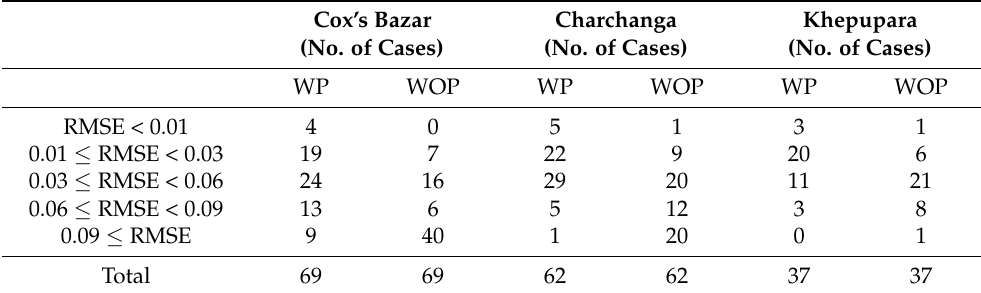
Table 1. The evaluation of the root mean square error (RMSE) for prediction with precipitation (WP) and without precipitation (WOP).